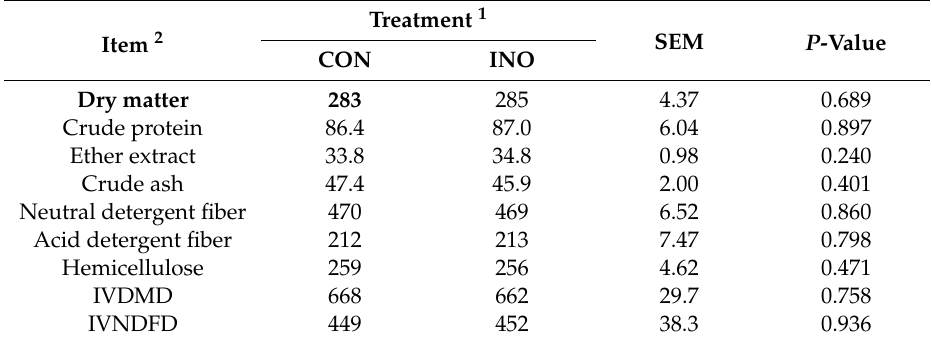
Table 3. Chemical compositions of corn forages before ensiling (g / kg dry matter